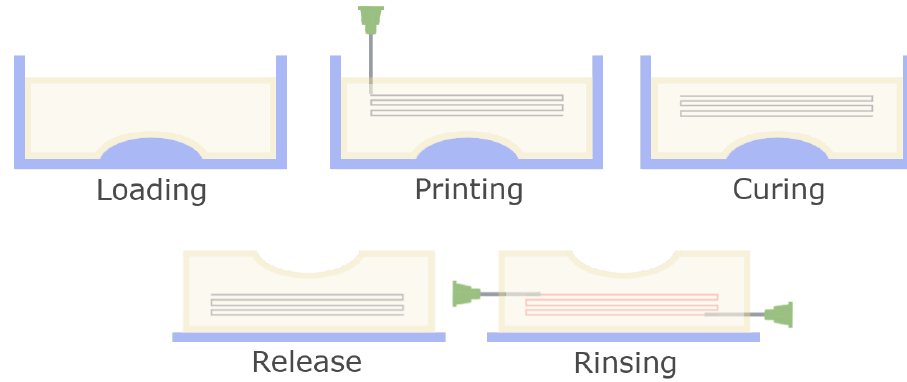
Figure 1. Schematic overview of the fabrication process for 3D structures. After the slurry is loaded into the mould, a channel pathway is printed using a fine nozzle. Then, the matrix is cured to create a homogenous, stable structure. Afterwards the device is released from the mould and the printed sacrificial material is removed by rinsing.